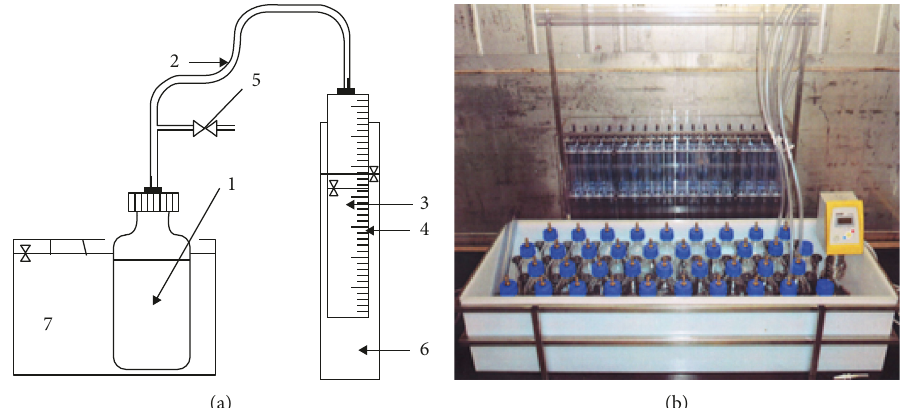
Figure 1: (a) The biogas reactor.1:1L glass bottle; 2: connection hose; 3: gas volume; 4: length scale; 5: valve; 6: saturated brine tank; 7: tray. (b) Photograph of the biogas